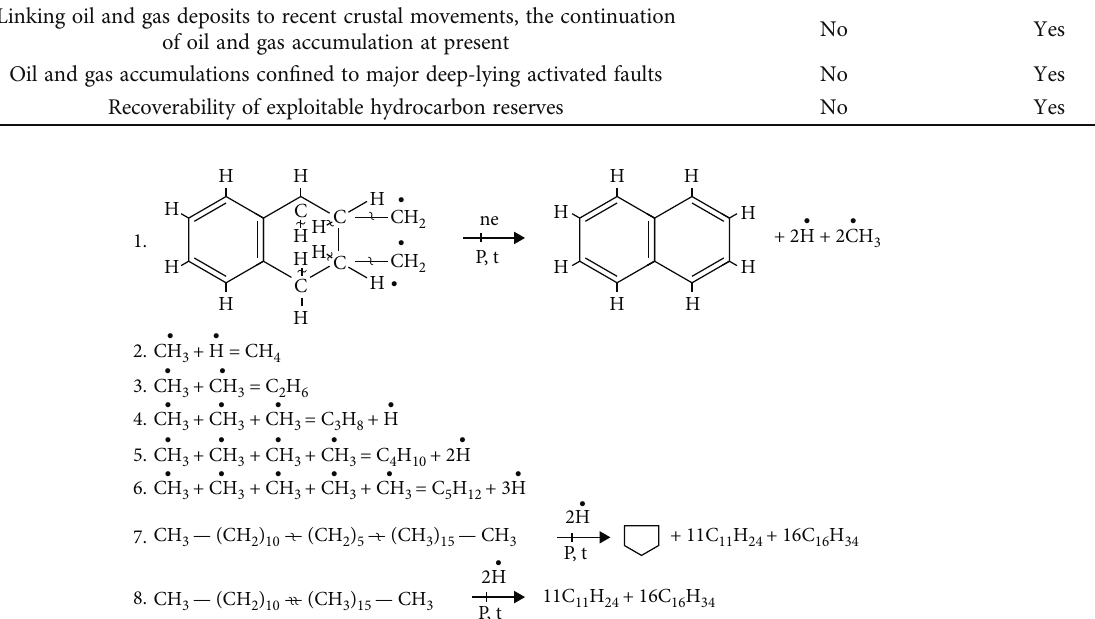
Figure 1: Schematic diagram of hydrocarbon generation from organic matter. P is the reservoir pressure, T is the reservoir temperature, and ne is the stress state of reservoir